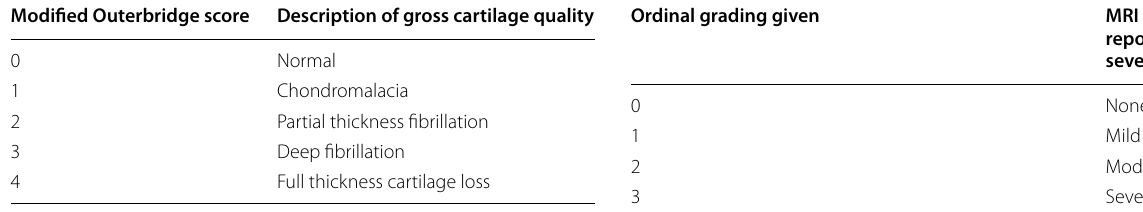
Table 2 Modified Outerbridge classification Modified Outerbridge score